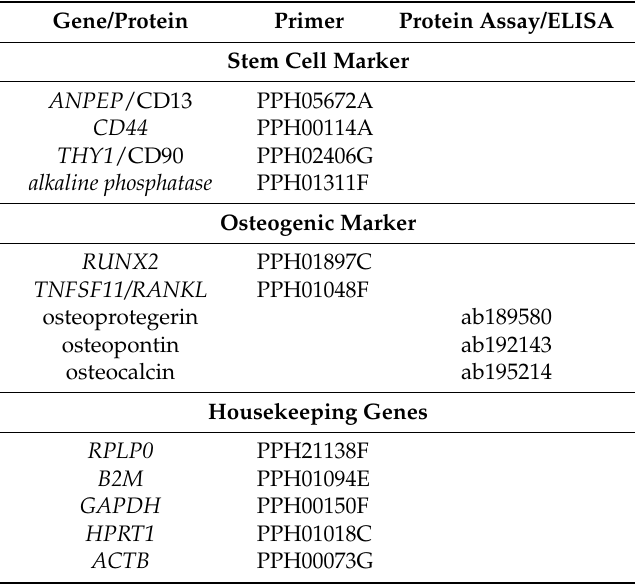
Table 2. Used and primer (Qiagen, Hilden, Germany) and enzyme-linked immunosorbent assay (ELISA)-Kits (abcam, Cambridge, England). Gene/Protein Primer Protein Assay/ELISA Stem Cell Marker ANPEP /CD13